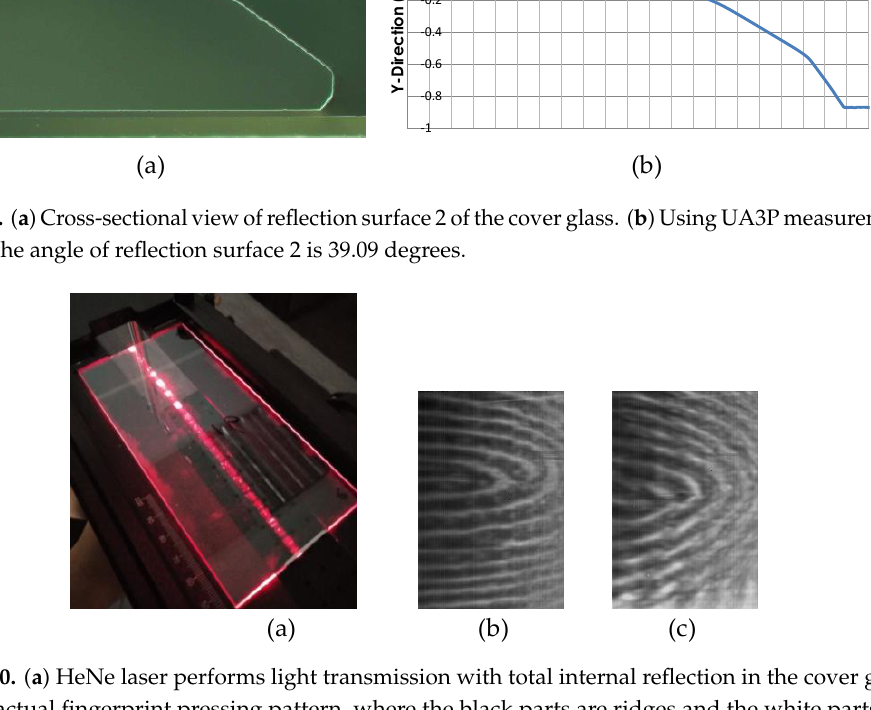
Figure 10. ( a ) HeNe laser performs light transmission with total internal reflection in the cover glass. ( b ) The actual fingerprint pressing pattern, where the black parts are ridges and the white parts are valleys. ( c ) The actual fingerprint image formed by infrared LED light source.